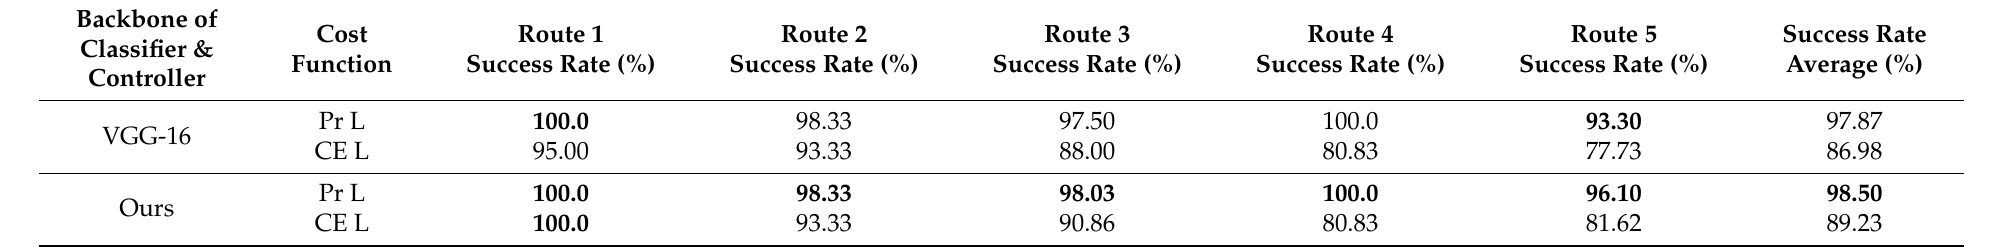
Table 10. The experiment results of the proposed system for mobile robot localization and navigation in the real apartment. PR-L and CE-L indicate the proposed loss and Cross-Entropy loss,